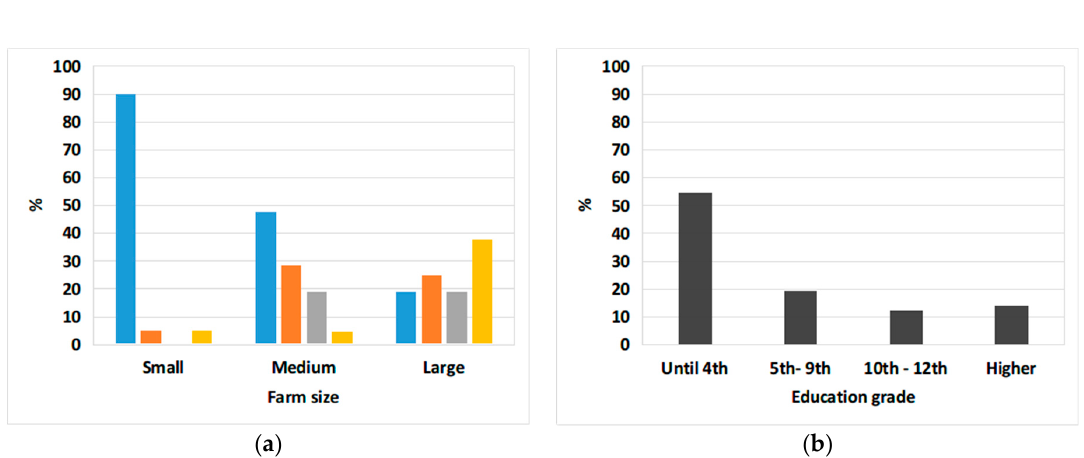
Figure 4. Relative frequency (%) of relevance of agricultural activity of respondents by: ( a ) the farm size (Main activity and source of income, ; Secondary activity that supports family income, ; Without relevance, ), and ( b ) the overall responses. Farm size: Small (lower than 25 m 2 ), Medium, Large (over 8.5 ha). The farmers’ motivation for the practice of agriculture is mainly explained (in 73% of the responses) by the combination of several factors: (i) it is a family activity (30% of the answers); (ii) the owner has the possibility to continue a business that already existed in the family; (iii) the existence of land, inherited or acquired, that is intended to be monetized; (iv) they are landlords who rent the parcels, and the benefit they get from the land is the financial income and not the agricultural activity itself; and (v) the family farming encompasses elements associated with family values, such as